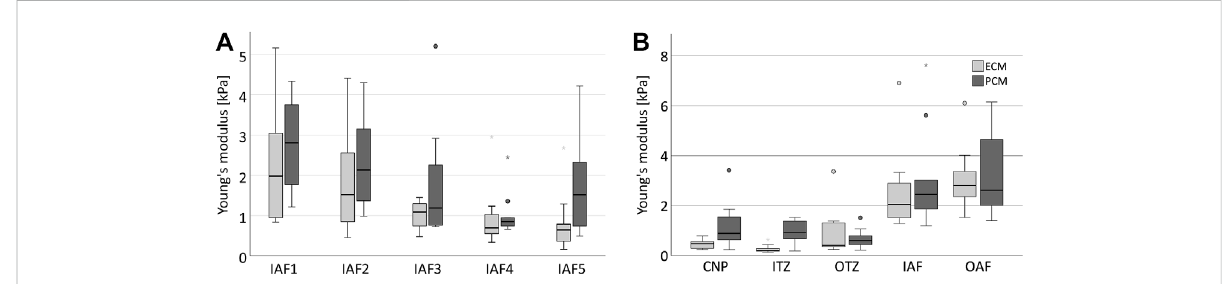
FIGURE 3 Stiffness depends on the localisation in the disc. Boxplots showing the results for ECM (light grey) and PCM (dark grey) measurements for fi ve similar measurement areas in one single anulus fi brosus (A) and for fi ve different disc zones going from the centre to the periphery of the IVD measured in fi ve different bovine discs (B) . (A) It can be noted that a relevant variability of the data is measured even in the same type of tissue in the samedisc(ECM: p =0.001,PCM: p < 0.001,ECM/PCMratio: p =0.002).Thescopeofvariabilityis,however,comparableforeachECMandPCM testingwithinonesample. (B) ThestiffnessofECMandPCMappearstoincreasefromthecentraldisctotheouteranulus.Abbreviations:CNP,central nucleus pulposus; IIZ, inner intermediate zone; OIZ, outer intermediate zone; IAF, inner anulus fi brosus; OAF, outer anulus fi brosus.